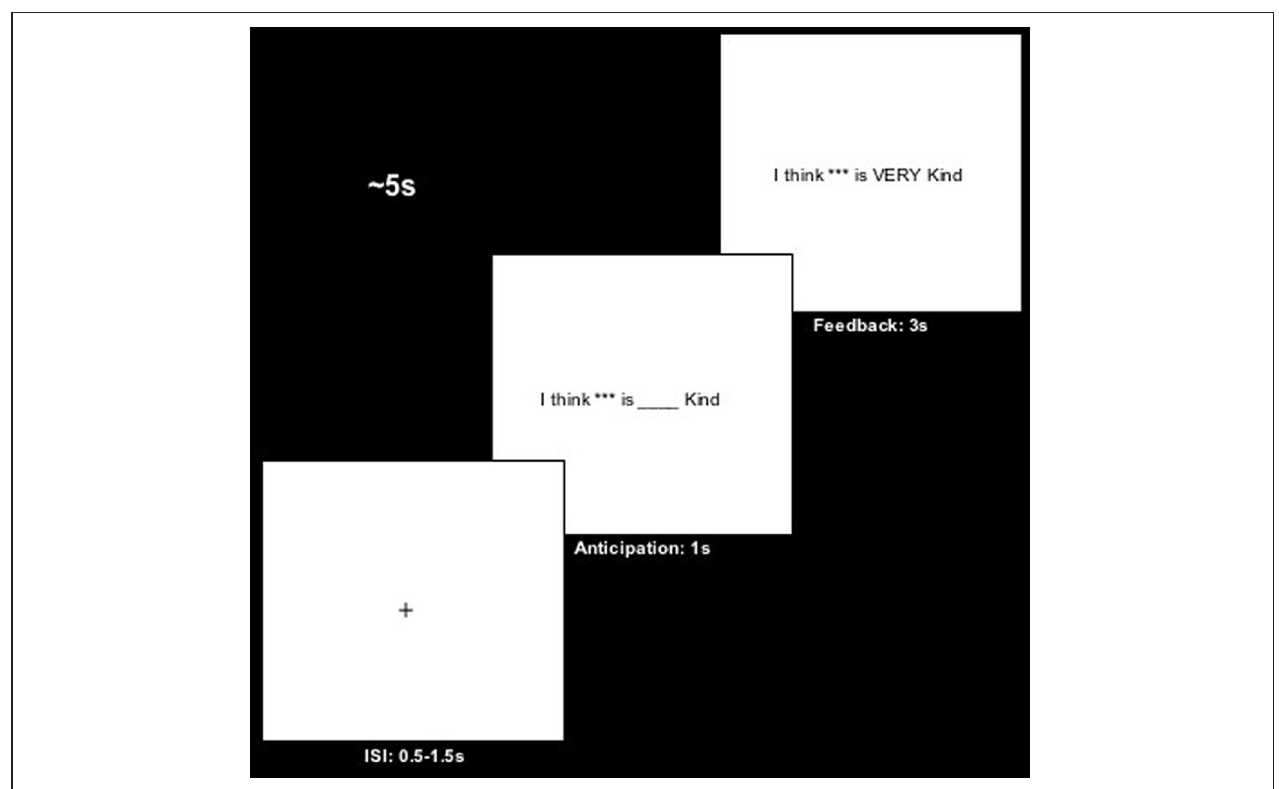
FIGURE 1 | Schematic depiction of trials within blocks. Trials were composed of a.5–1.5s interstimulus interval (ISI; M = 1s). This was followed by a 1s anticipatory event, which presented participants with statements